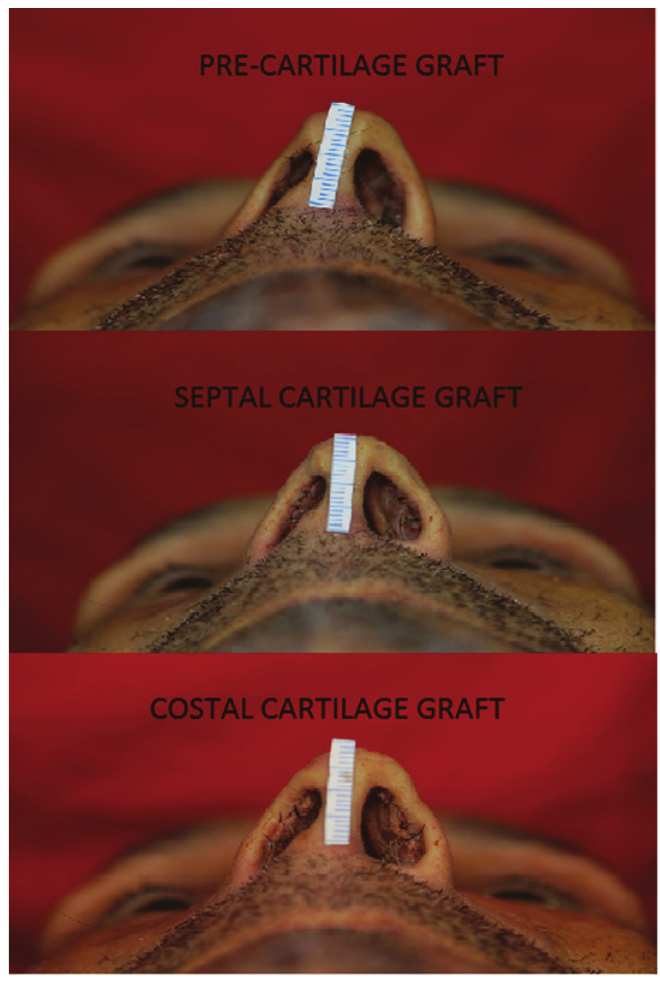
FIGURE 6 - Pictures of the nostrils before the insertion of grafts (“pre”) and after the inclusion of “septal”/”costal”